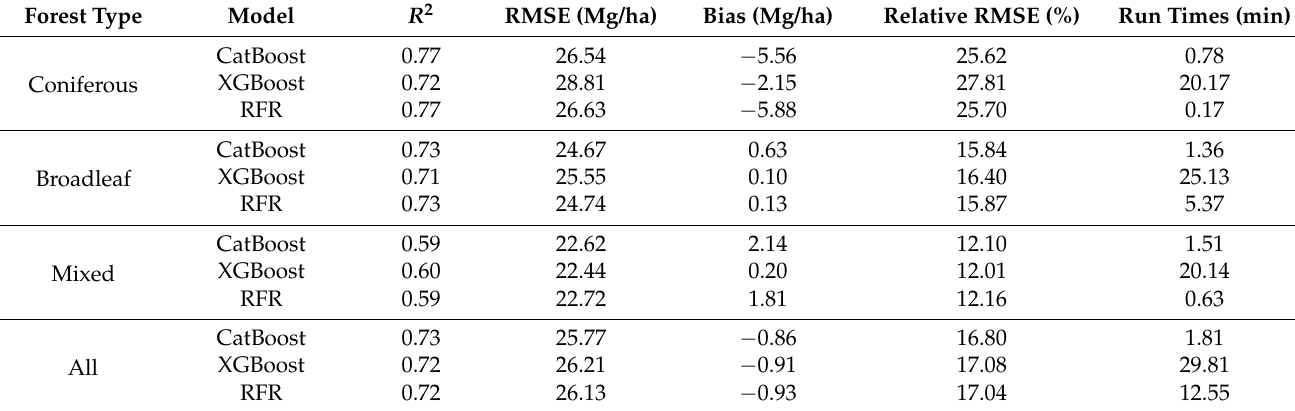
Table 5. AGB estimation accuracy assessments on validation dataset by combining RFE with machine learning algorithms (CatBoost, XGBoost, RFR) for different forest types. Forest